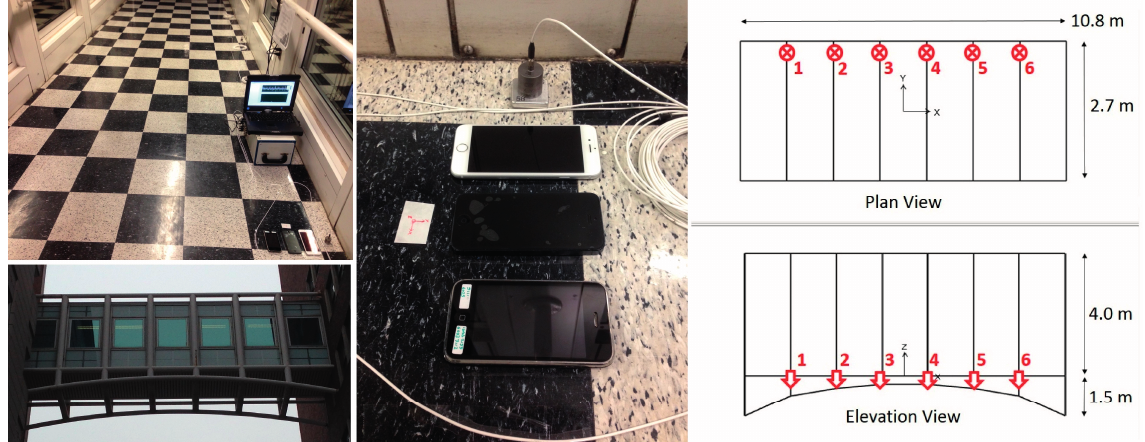
Figure 5. Inner and outer views, dimensions, and sensor layout of the pedestrian link